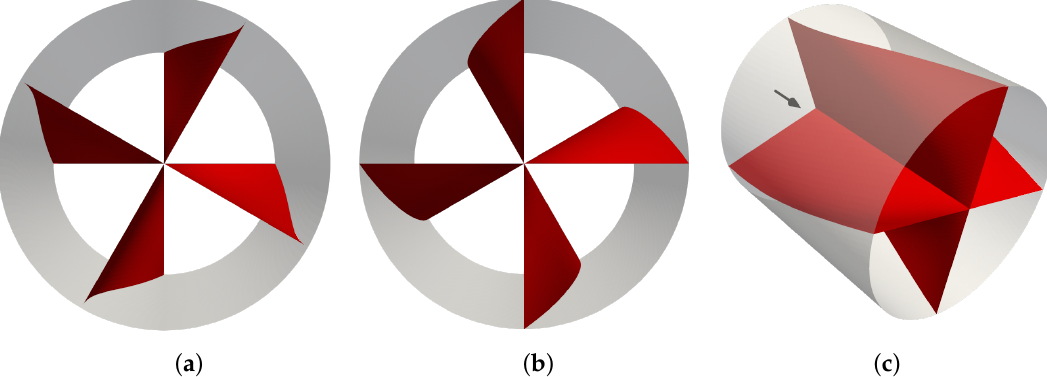
Figure 12. Swirler design with varying deviation angle at the exit, visualized ( a ) downstream (left); ( b ) upstream (center) and ( c ) under an angle